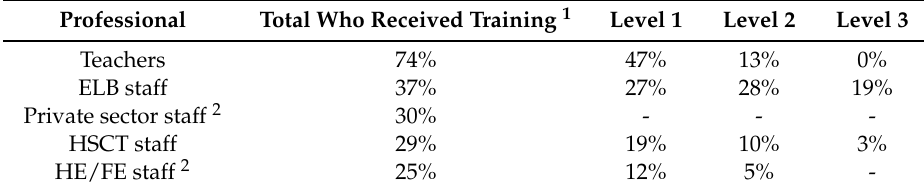
Table 1. Proportion of professionals who completed autism training at Levels 1, 2, and 3.